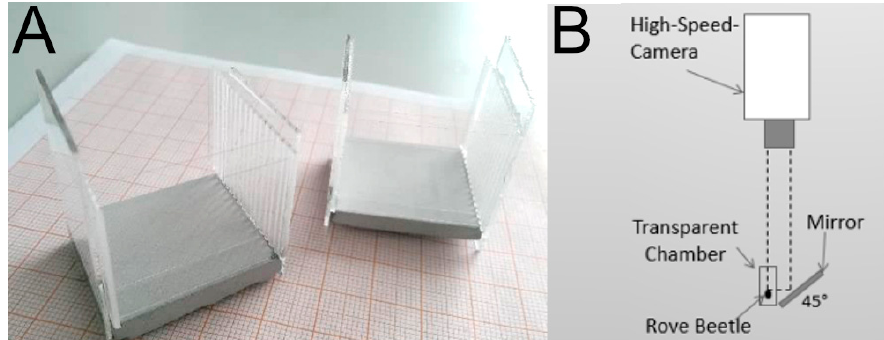
Figure 3. ( A ) Chambers used for filming were adjustable in width to accommodate the various sizes of beetles. They were all 35 mm in length and 25 mm in height. A microscopy cover glass was used to close the top of the chamber to prevent beetles from escaping. ( B ) Experimental setup for the filming process (side